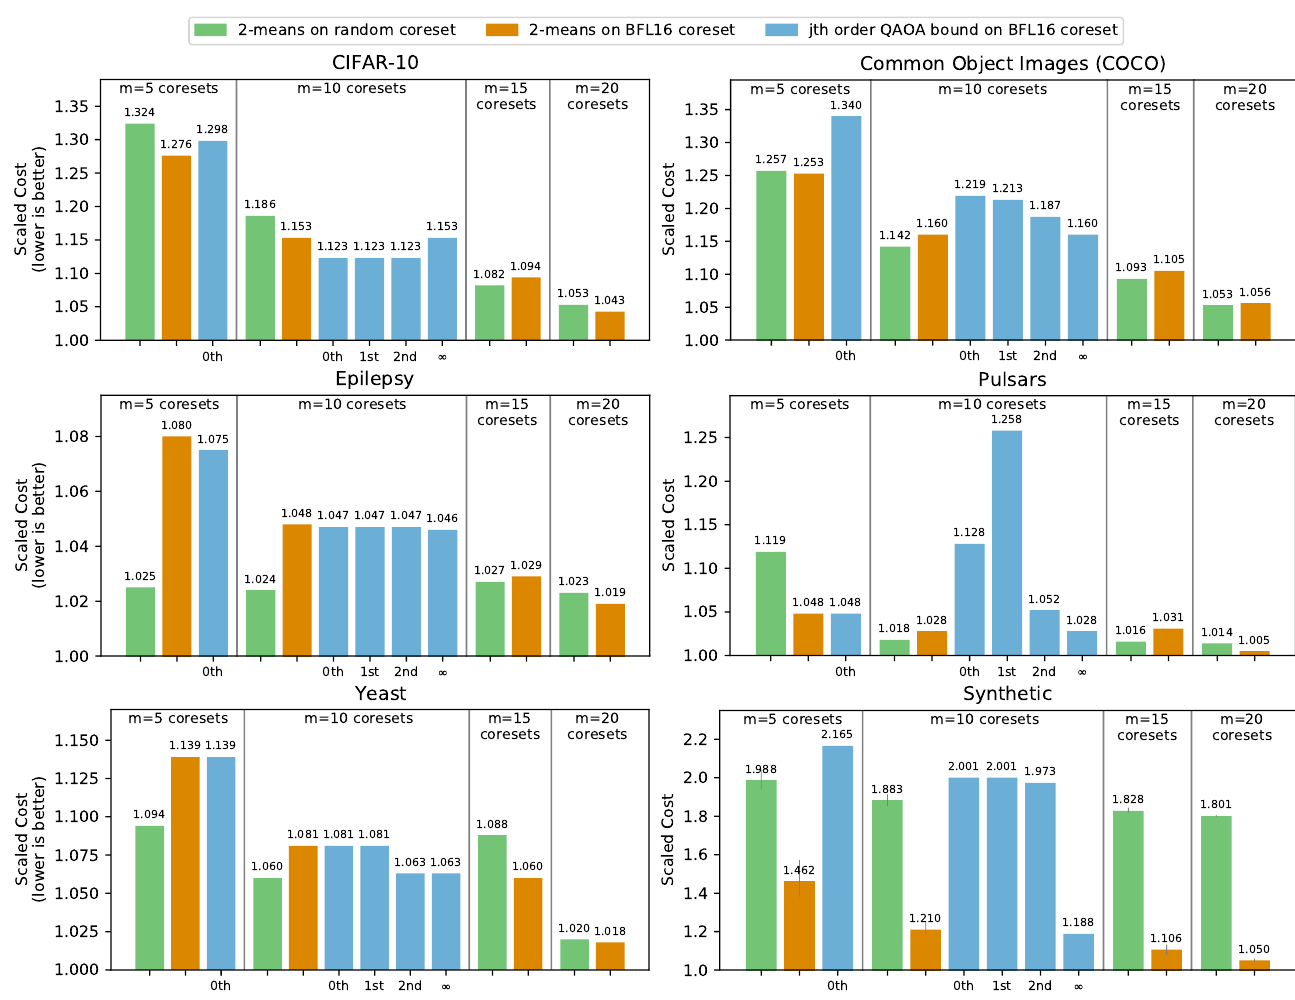
Figure 3. Evaluation of quantum and classical coreset clustering on six different data sets. The green and orange bars were obtained by running classical 2-means on m = 5,10,15, and 20 random and BFL16 coresets, respectively. The blue bars express the cost of the highest-eigenstate of the m = 5 and 10 Hamiltonians using a j -th order Taylor expansion. These can be interpreted as bounds on QAOA’s performance with m qubits. We report the best of 10 results for all data sets, except for the synthetic one, which shows the means and min-max error bars. All costs are scaled with respect to the cost achieved by running 2-means over the full data